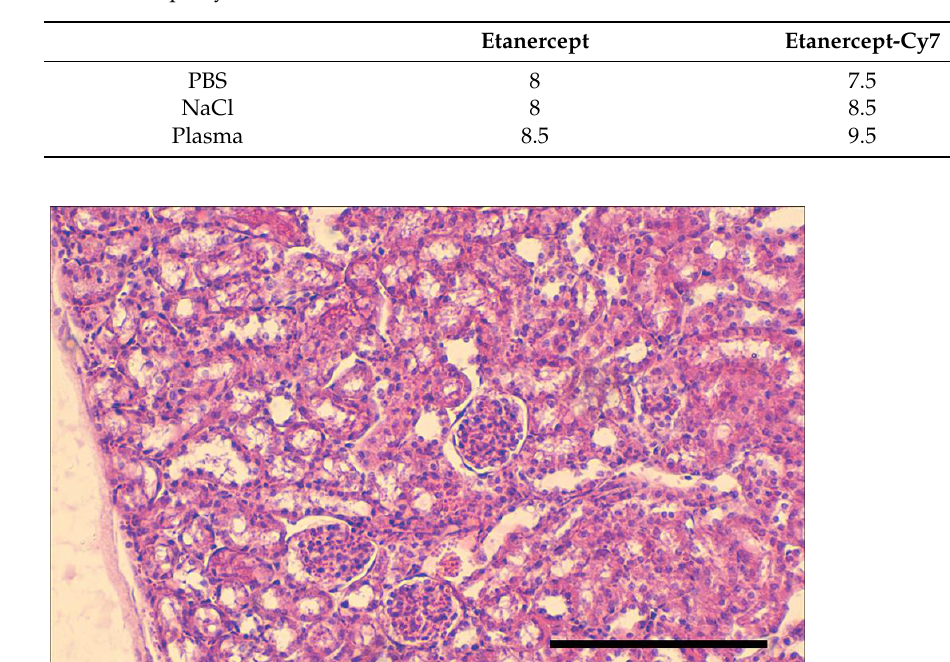
Figure A2. The histological image of the kidney 5 days after the microcapsules injection shows that the renal tissue has a normal structure. The thickness of the histological samples is 5 μm; dyes: hematoxylin and eosin. The scale bar is 200 µm.